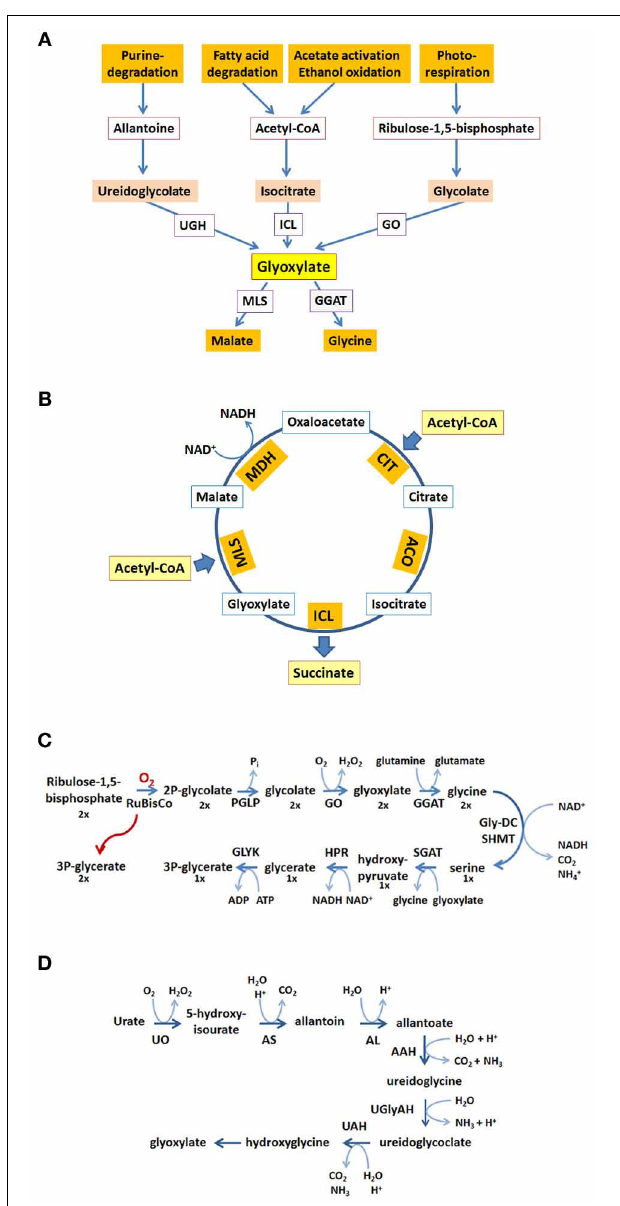
FIGURE 1 | Glyoxylate generation and consumption. (A) Glyoxylate is generated from different precursor molecules and converted into stable metabolites for further utilization. The proteins involved are ureidoglycolate hydrolase (UGH), isocitrate lyase (ICL), glycolate oxidase (GO), malate synthase (MLS), glutamine:glyoxylate aminotransferase (GGAT). (B) In the glyoxylate cycle two acetyl-CoA are condensed to succinate and 2 CoA (not shown). The proteins involved are citrate synthase (CIT), aconitase (ACO), isocitrate lyase (ICL), malate synthase (MLS), malate dehydrogenase (MDH). (C) The generation and consumption of glyoxylate in the photorespiratory process. The stoichiometry of the reaction sequence to obtain three molecules of 3-phospho-glycerate from two oxygenation products of ribulose-1,5-bisphosphate is indicated by the numbers below the molecules (1 × , 2 × ). The proteins involved are ribulose-bisphosphate-carboxylase-oxygenase (RuBisCO), phosphoglycolate phosphatase (PGLP), glycolate oxidase (GO), glutamine:glyoxylate aminotransferase (GGAT), glycine-decarboxylase